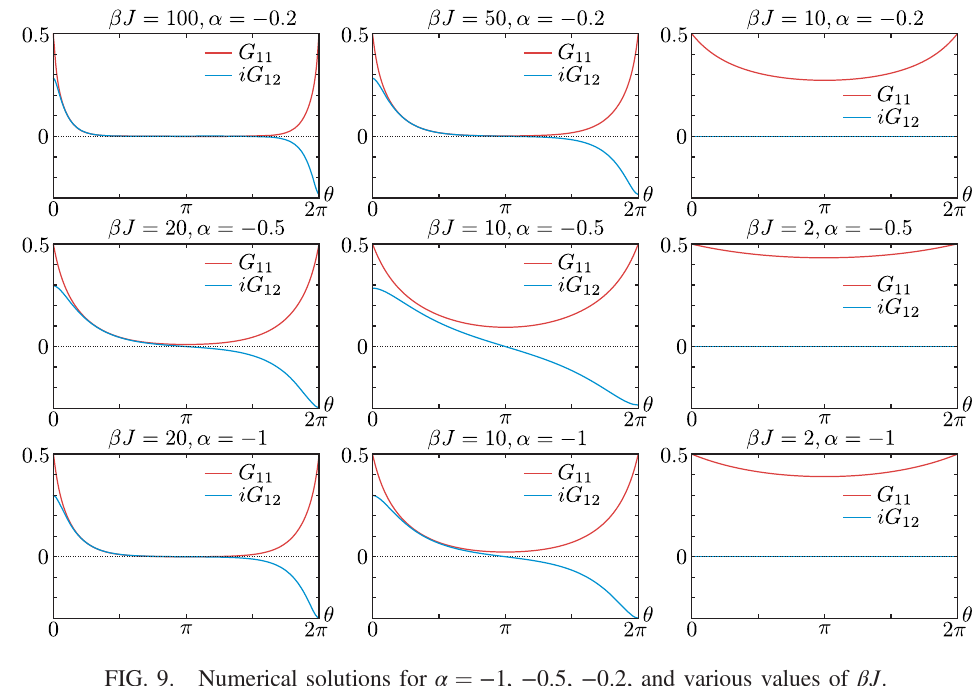
FIG. 9. Numerical solutions for α ¼ − 1 , − 0 . 5 , − 0 . 2 , and various values of β J .